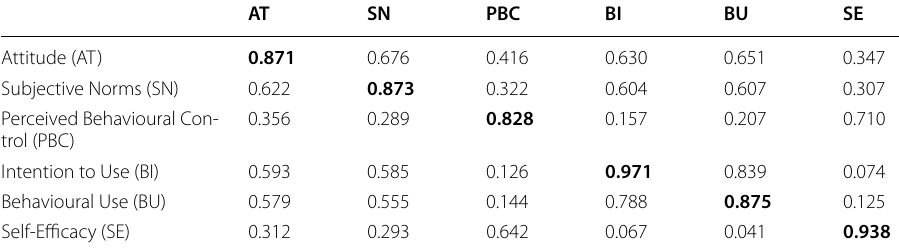
Table 5 Discriminant